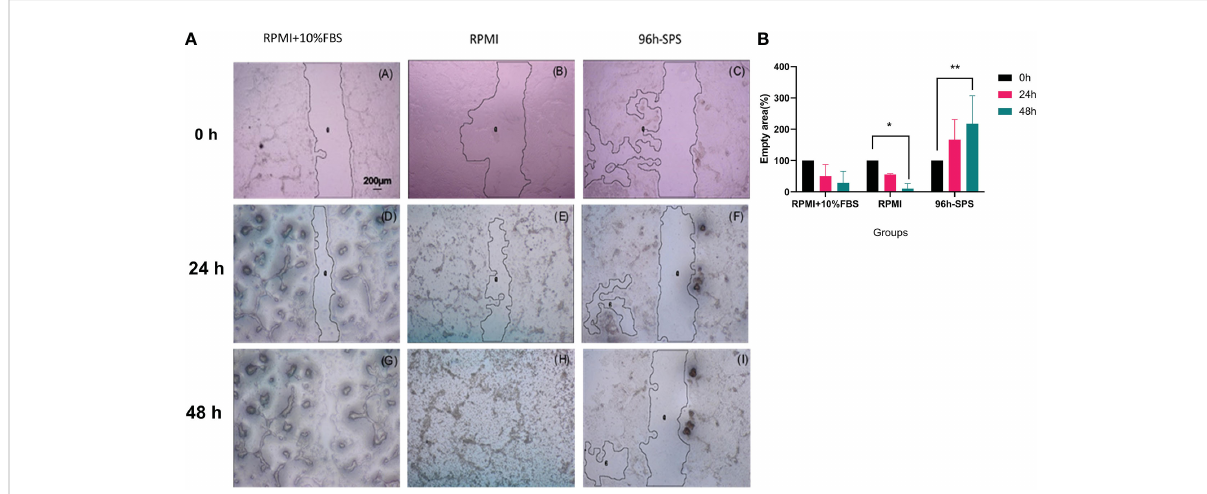
FIGURE 2 (a) LA7 scratch test photomicrographs. Cells culture plate scratched by 100- m l micropipette tip and exposed to the three indicated solutions for 24h and 48h. These data showed that the indicated 96 h-SPS group were able to inhibit the LA7 cells migration (C, F, I) , whereas the empty area was almost not observed in complete medium (A, D, G) , and RPMI group (B, E, H) after 48h. Magni fi cation: 40×. By using image J software (NIH, USA), the relative empty area was calculated. (b) Quanti fi cation of the indicated empty area of LA7 cell migration under the in fl uence of complete medium, RPMI, and 96 h-SPS group after 0h, 24h, and 48h cell incubation. The 96 h-SPS – treated LA7 cells showed a signi fi cant reduction in cell migration in comparison with RPMI. The empty area after 48h of cell incubation was signi fi cantly increased in this group compared with the initial empty area at 0h ( p = 0.006), whereas this area was signi fi cantly decreased in RPMI group ( p = 0.036). Data expressed as mean ± SD ( n = 5). Bars indicate the SD. In each panel, * p < 0.05, ** p <